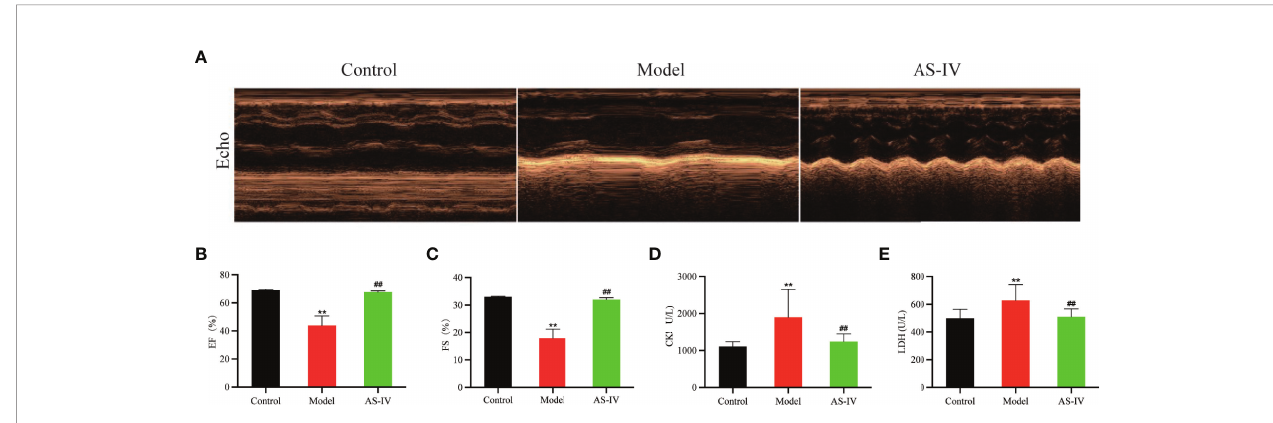
FIGURE 3 | Effects of AS-IV on ISO-induced cardiac dysfunction and myocardial damage in mice. (A) Representative echocardiography; (B, C) Echocardiographic parameters, including EF and FS (n = 6); (D, E) Serum CK and LDH (n = 8). Mean ± SD. ** P < 0.01 (the control vs. the model group). ## P < 0.01 (the AS-IV vs. the model